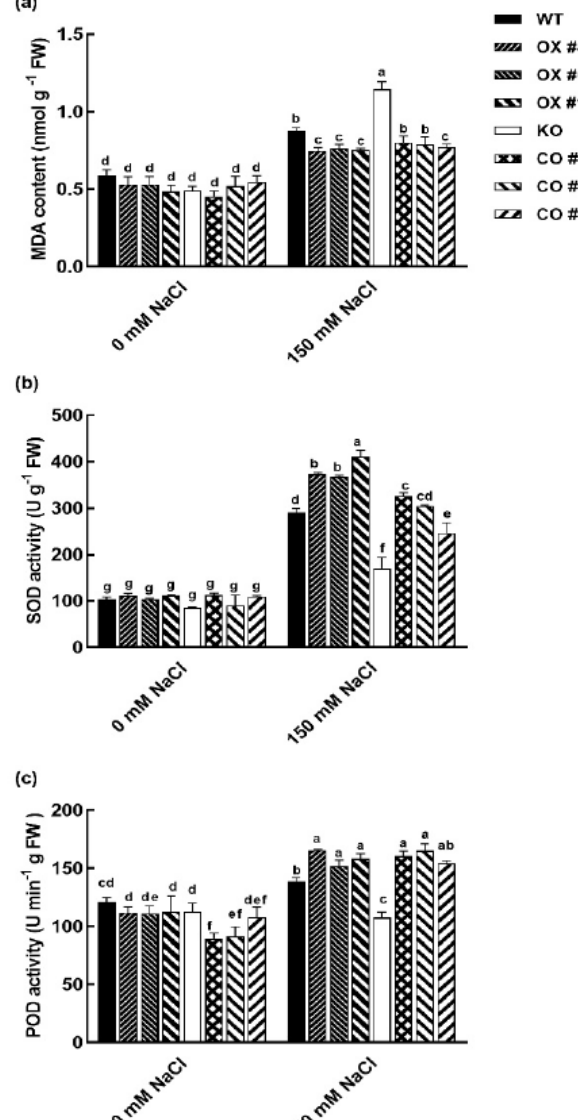
Figure 6. Effects of salt stress on the antioxidant enzyme system in the leaves of wild type (WT), BvbHLH93 -overexpression Arabidopsis (OX), atbhlh93 mutant (KO), and transgenic BvbHLH93 in the mutant (CO). ( a ) Leaf malondialdehyde (MDA) content. ( b ) SOD activity. ( c ) POD activity. Different letters indicate significant difference at p < 0.05. Three biological replicates were